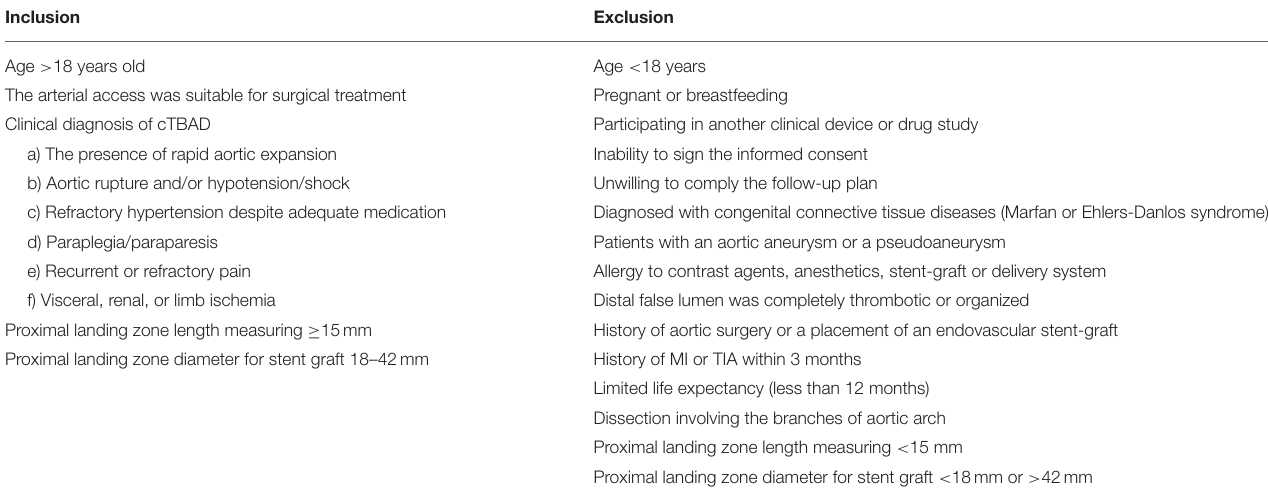
TABLE 1 | Inclusion & exclusion criteria.